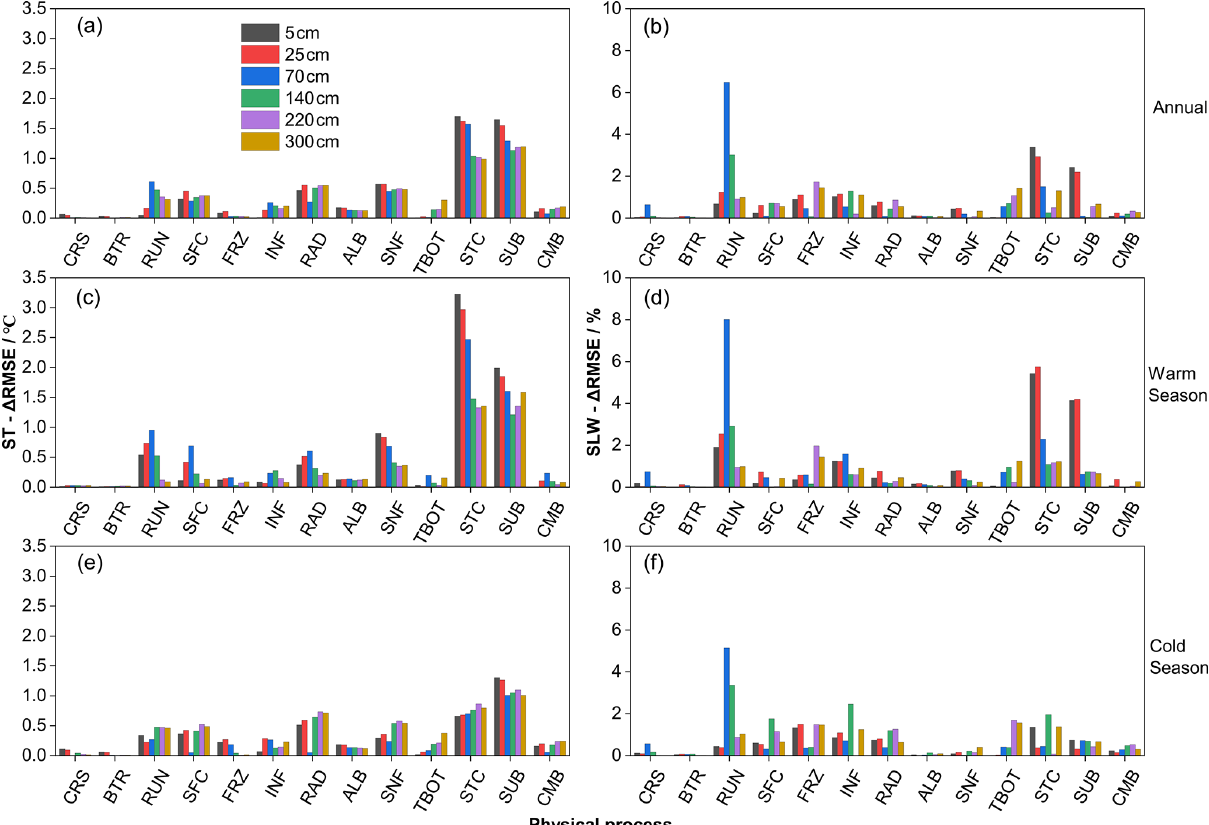
Figure 5. The maximum difference in the mean RMSE for (a, c, e) soil temperature (ST- (cid:49) RMSE, in ◦ C) and (b, d, f) soil liquid water (SLW- (cid:49) RMSE, in %) in each physical process (a, b) annually and during the (c, d) warm and (e, f) cold seasons at different soil depths at the TGL